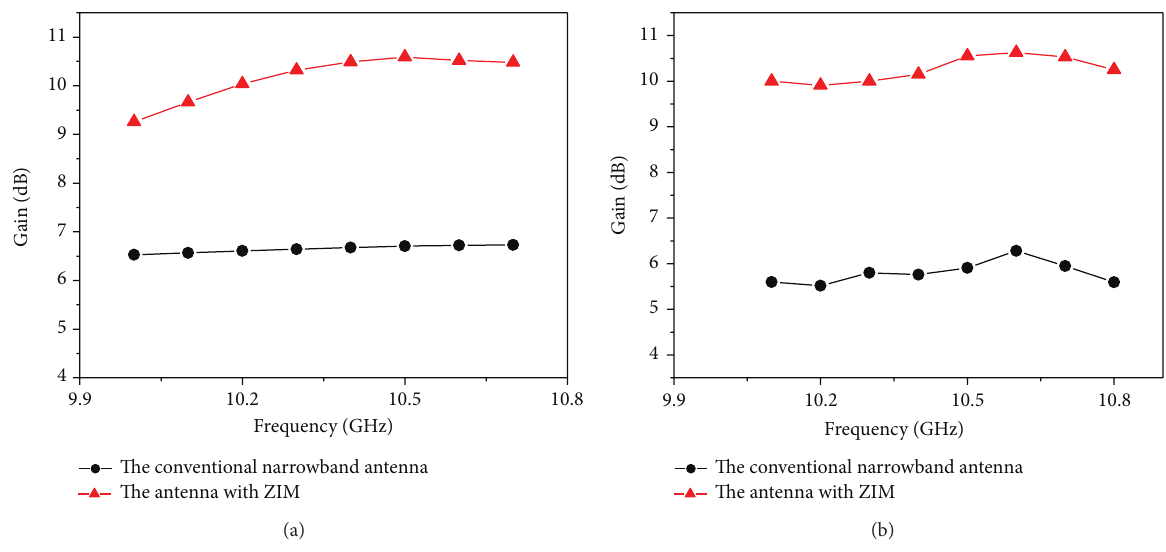
Figure 9: The comparative gains of the conventional narrowband antenna and the proposed antenna, (a) simulations and (b) measurements.